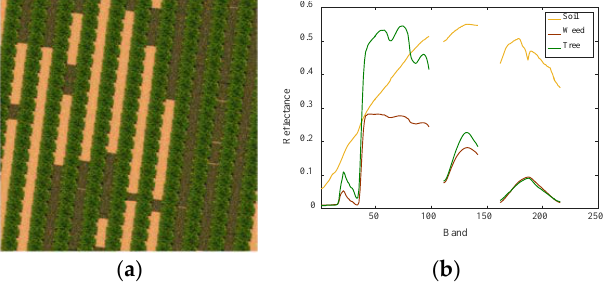
Figure 12. Virtual orchard dataset [34]: ( a ) high-resolution image (tree, soil and weed); ( b ) endmembers’ spectral curves. Table 11. Description of virtual citrus orchard scene.